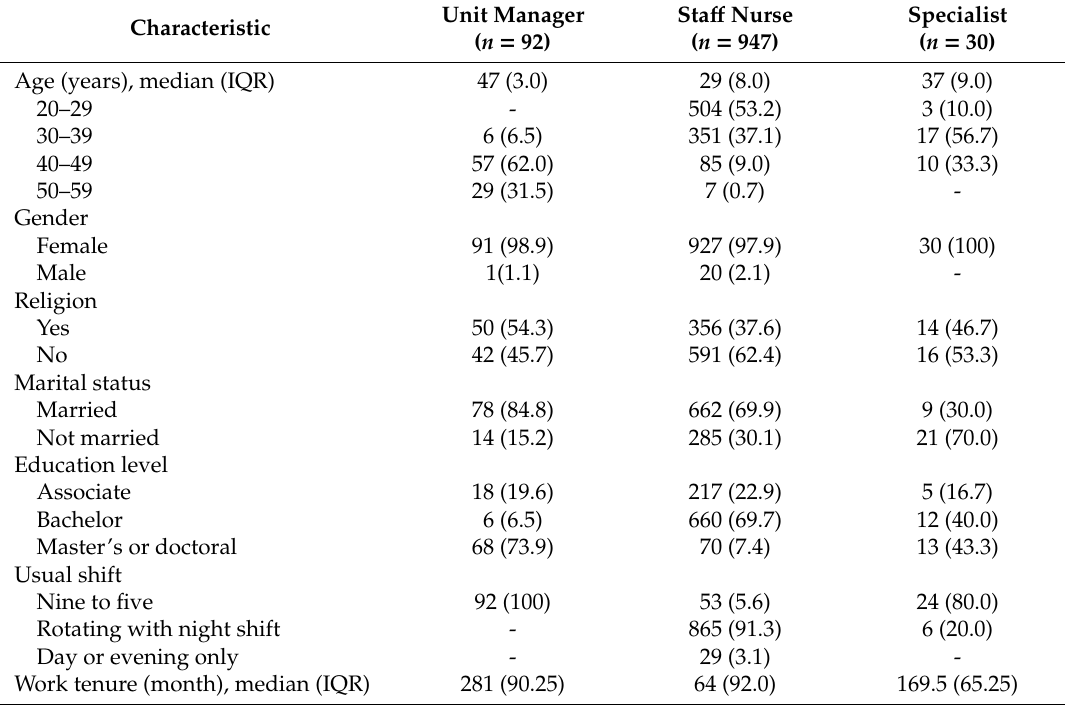
Table 1. Demographic characteristics of the